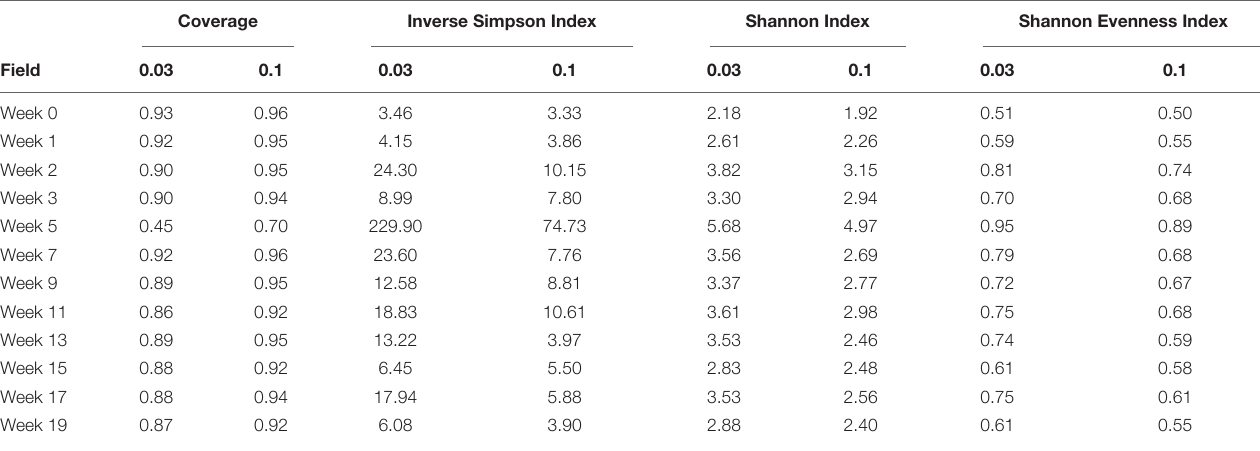
TABLE 3 | The coverage, diversity, and evenness indices at 0.03 and 0.10 genetic distances of bacteria associated with A. diaperinus larvae from the Spent litter the weeks after it was placed into the pastureland.